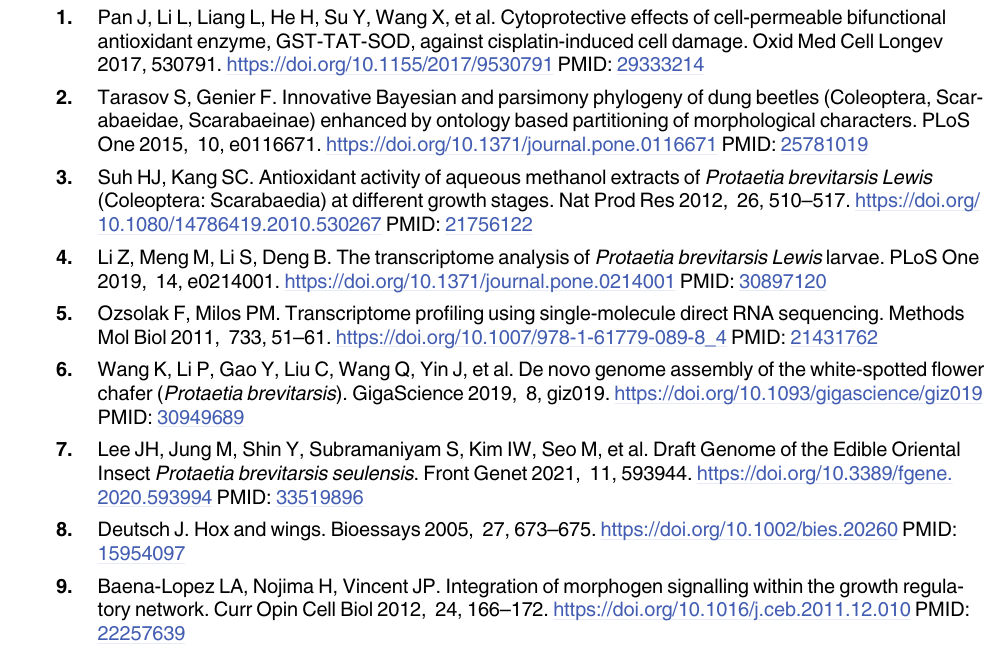
S2 Table. Wing development related gene ontology and number of genes in Protaetia bre- vitarsis seulensis . S3 Table. Lists of wing development related genes. S4 Table. Lists of metamorphosis related